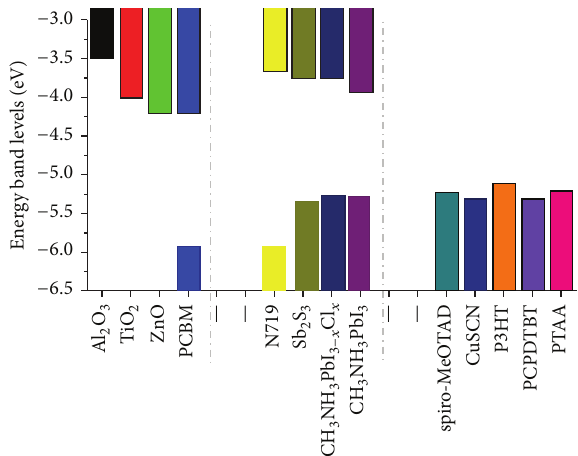
Figure 4: Energy level illustration for different ETM (left), absorbers (center), and HTM (right) in solar